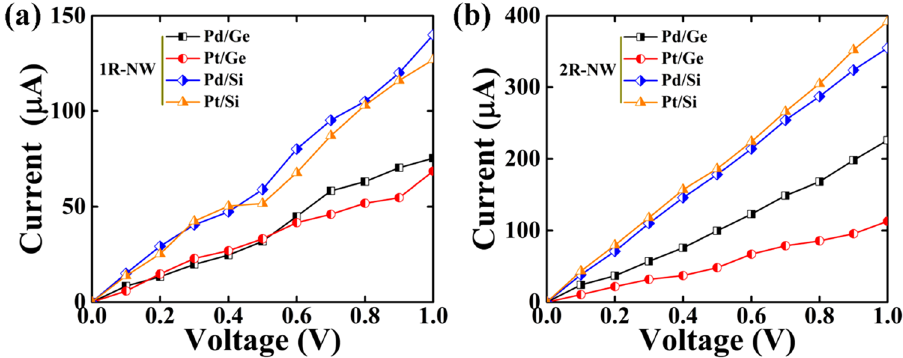
Figure 4. Current–Voltage (I–V) plot for ( a ) 1R and ( b ) 2R core–shell NWs for bias voltages from 0 to 1